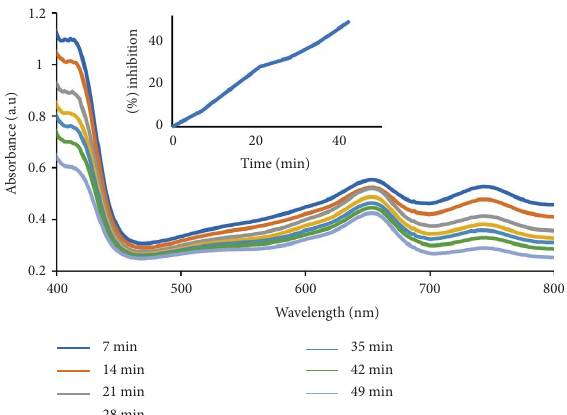
Figure 10: ABTS radical cation scavenging potential of cellulose/MoS